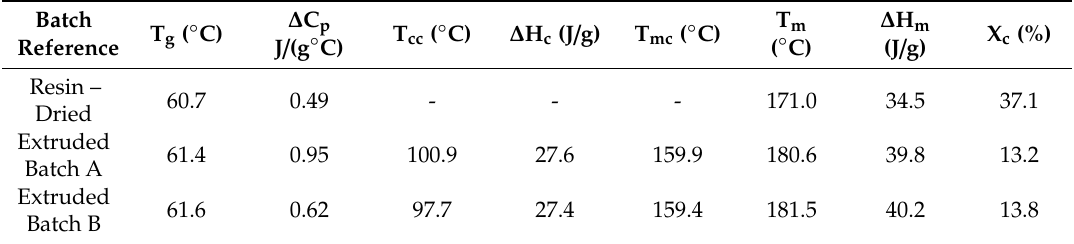
Table 4. Summary of thermal properties of dried PLLA dried resin and Batch A and B extruded